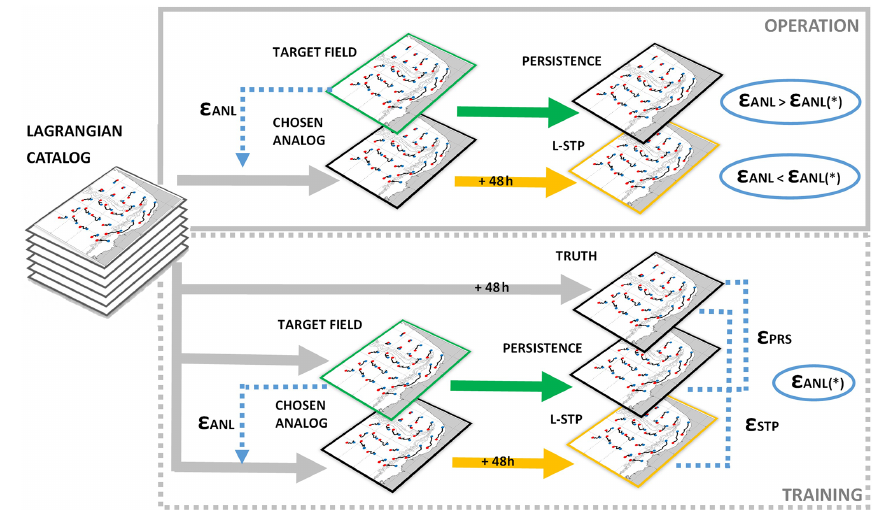
Figure 4. Scheme of the analog selection and L-STP forecast assessment process.